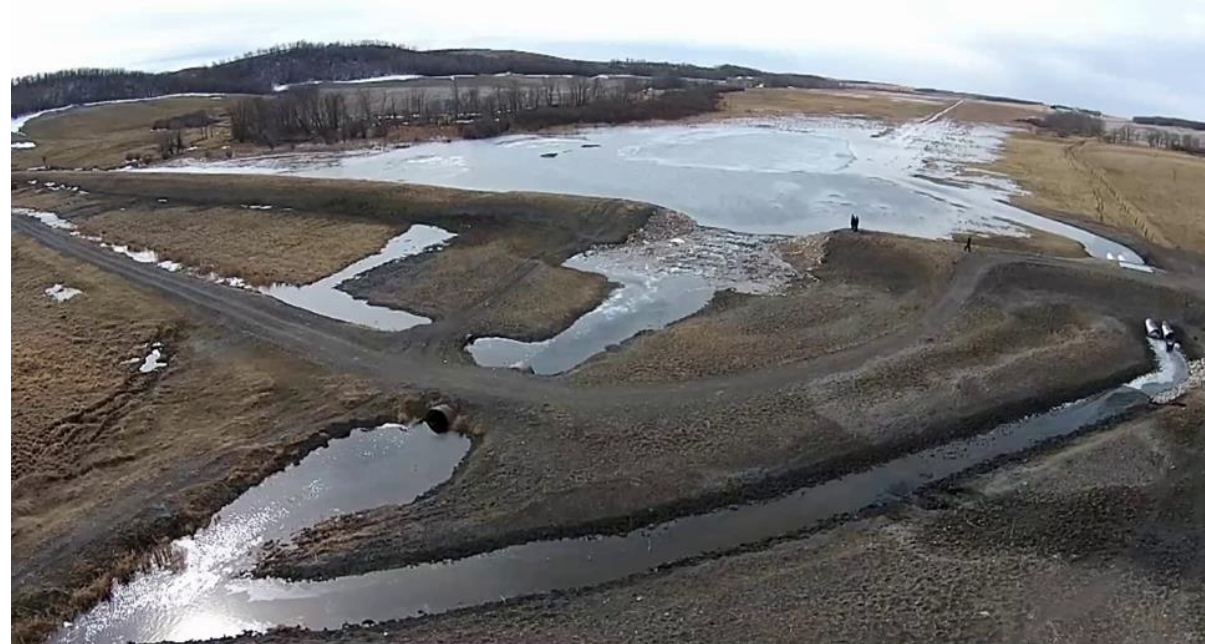
Figure 2. Aerial view of the Pelly’s Lake Water Management Project in operation retaining spring runoff water (20 March 20 2015). Wetland habitat extends to the horizon, areas of harvested cattail in the deepest section closest to the earthen dam is fully under water. Opening of the gated culverts (right side of photo) will lower water levels allowing new wetland habitat to emerge. The ability to control water levels allows for autumn harvest of